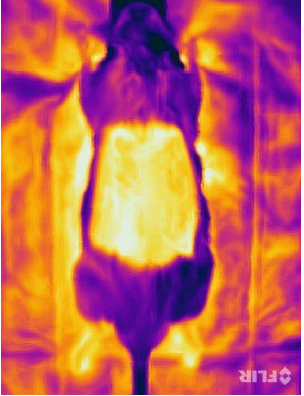
Figure 10. Infrared thermography on day 14 in group